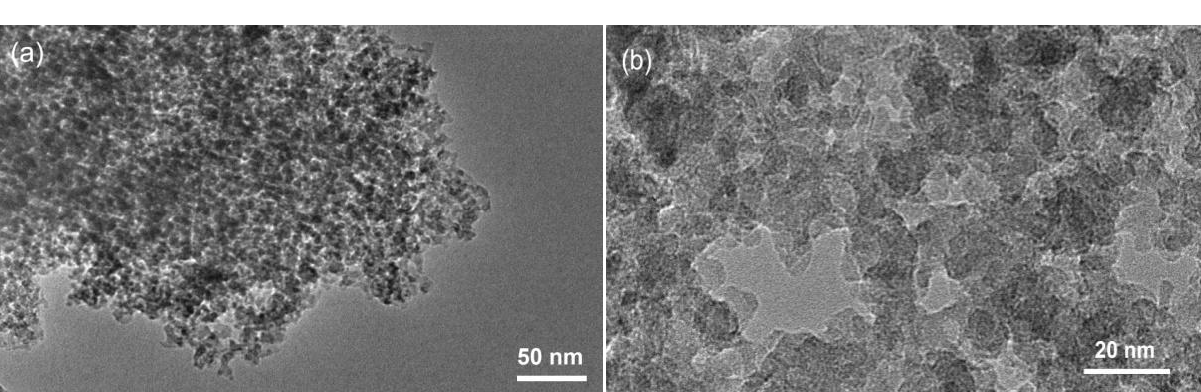
Figure 1. ( a ) Transmission electron microscopy (TEM) micrographs of 02-FeKIL-2 agglomerate;